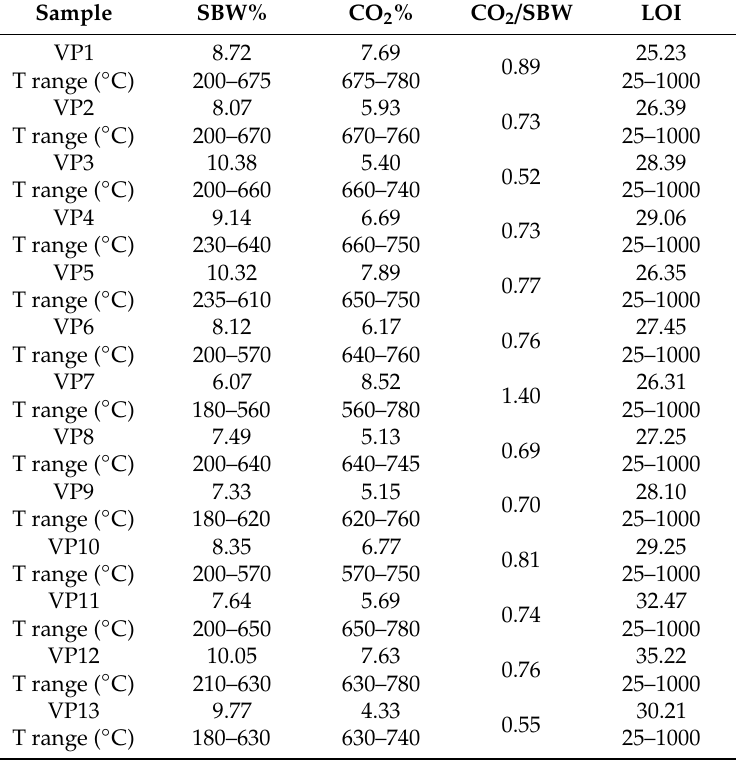
Figure 9. Binary CO 2 / SBW vs. CO 2 (%) diagram utilized to compare the obtained data from Villa del Pezzolo mortars (VP samples; dark grey diamonds) and those of Moropoulou et al. [31]; (NPM: natural pozzolanic mortars; APM: artificial pozzolanic mortars; HLM: hydraulic lime mortars; LM: lime mortars). Table 6. Thermal analysis features of investigated samples. Abbreviations: SBW: Structural Boundary Water; LOI: Loss on Ignition.